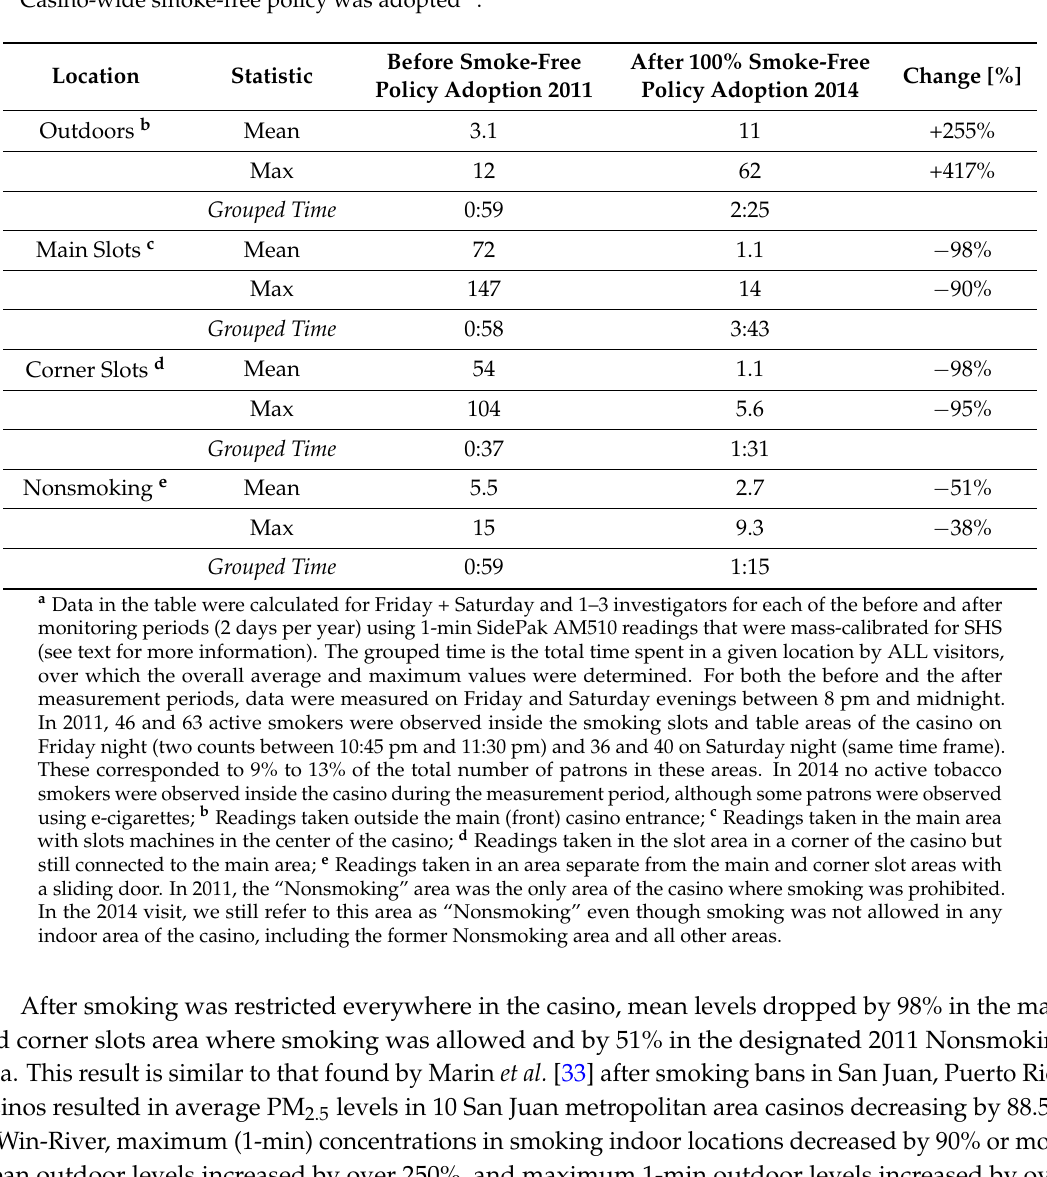
Table 1. Mean and maximum PM 2.5 [ µ g/m 3 ] from 1-min concentrations + grouped time ( HH:MM ) visitor personal-exposure measurements in four Win-River Casino locations before and after a 100% Casino-wide smoke-free policy was adopted a